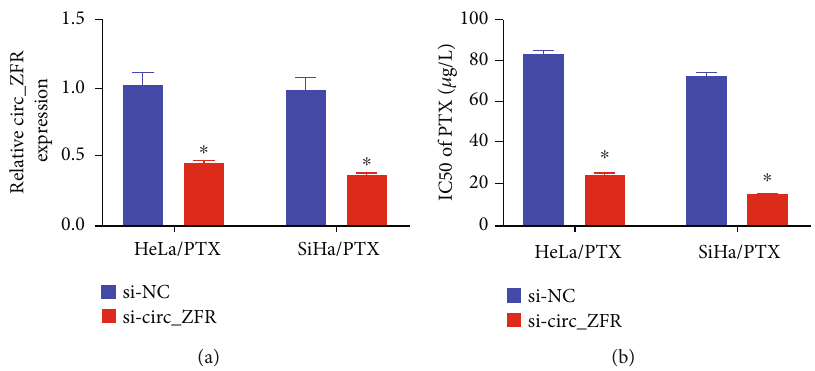
Figure 2: The suppression level of PTX resistance in circ_ZFR knockdown PTX-resistant CC cells. (a) The level of circ_ZFR expression in SiHa/PTX and HeLa/PTX cells. (b) The IC 50 values of PTX for SiHa/PTX and HeLa/PTX cells with ∗ p < 0 : 05